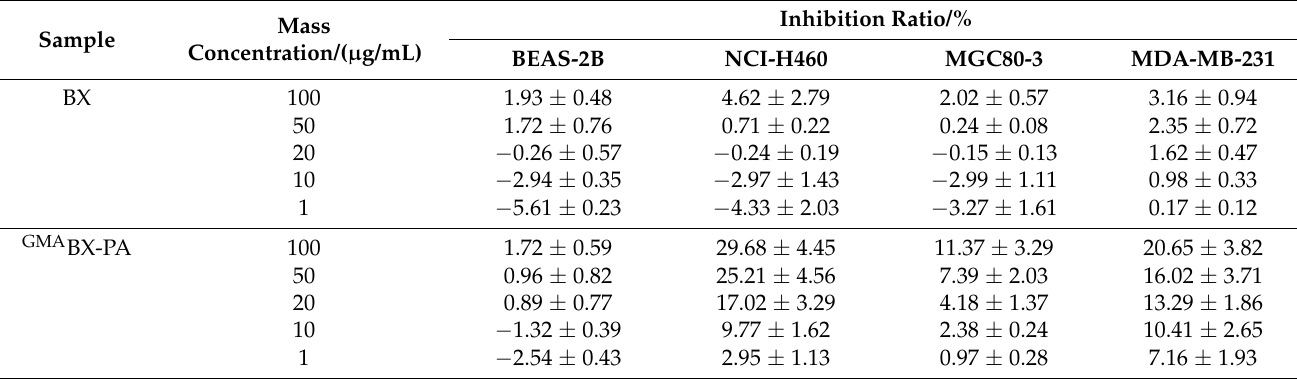
Table 4. The inhibition ratio of BX and GMA BX-PA on different cancer cells and normal cells.